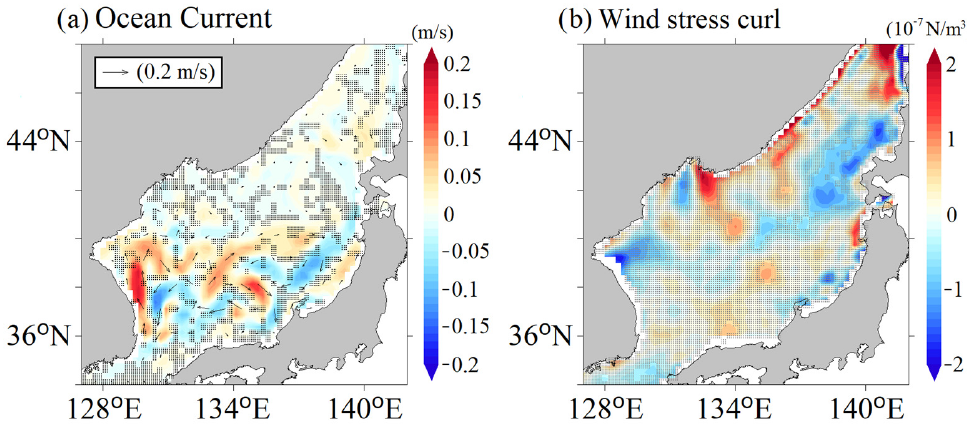
Figure 9. Composite difference of ocean currents and wind stress curl during the top third (strong) and the bottom third (weak) MHW characteristics (duration, coverage, mean intensity) in EJS in winter (strong–weak). The dotted areas indicate insignificant values at a 95% confidence level using Student t -test ( p -value > 0.05).